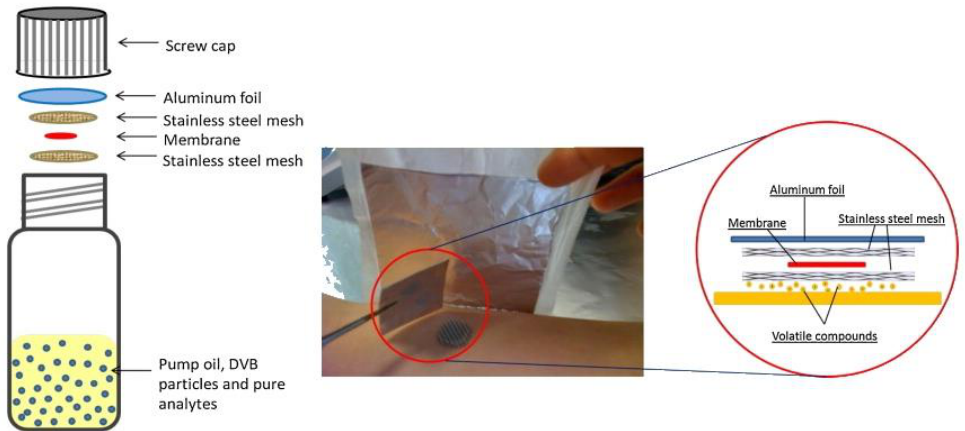
Figure 5. The development of polydimethylsiloxane (PDMS) TF-SPME devices for the analysis of skin volatiles. Reproduced from [35], with permission from Elsevier, 2013.